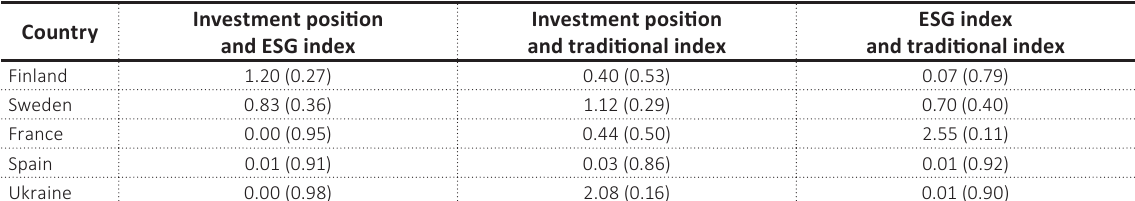
Table 4. ANOVA analysis of the dynamics of a country’s investment position, ESG index and traditional